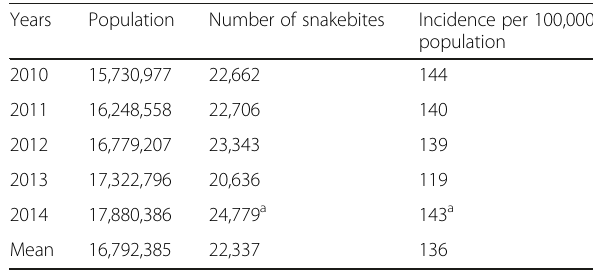
Table 1 Annual incidence of snakebites in Burkina